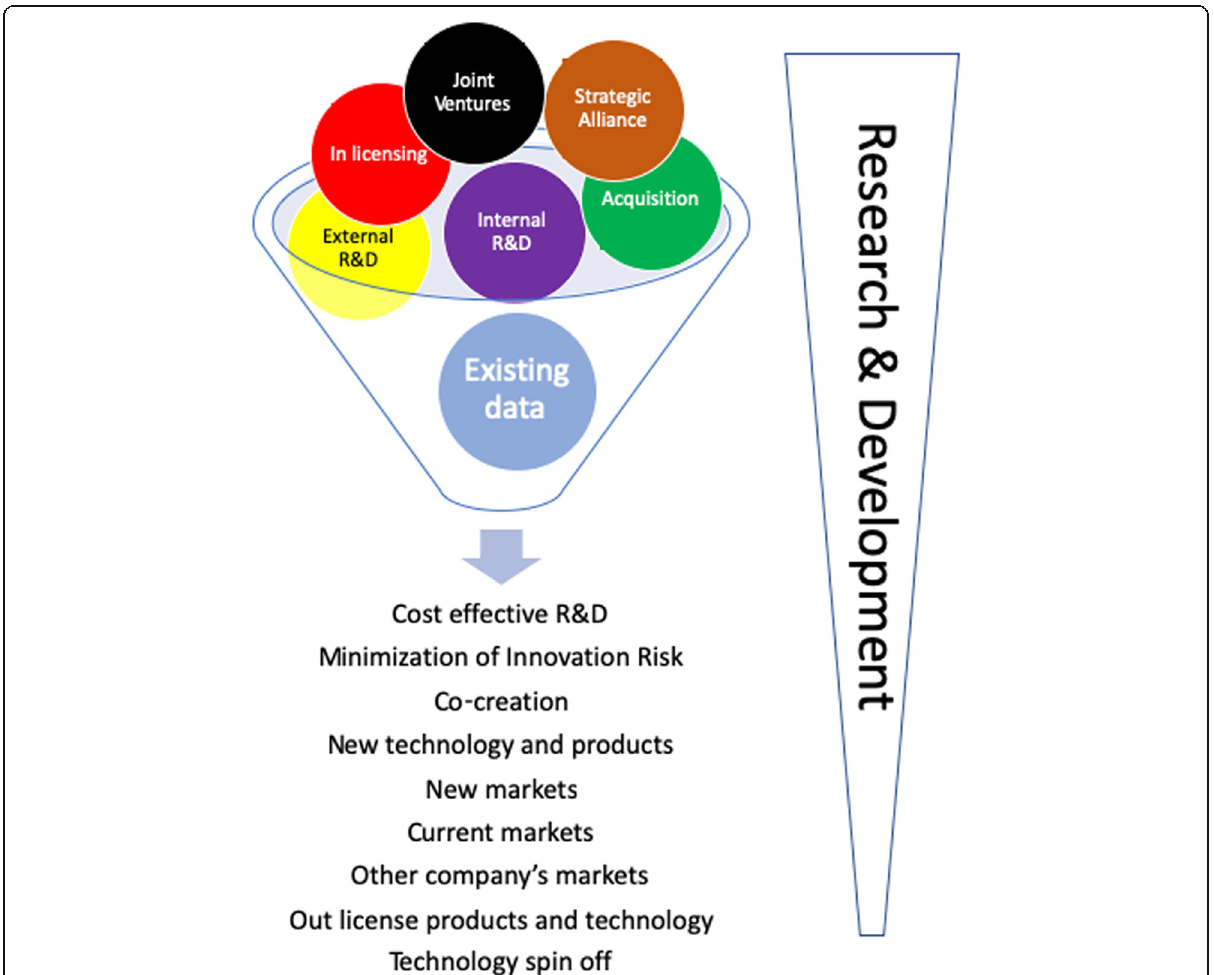
Fig. 4 Open Innovation Model emphasizes integrative science through collaboration, strategic alliance, open-sharing of internal R&D and external R&D, using existing knowledge (data), taking up other multifaceted approaches and accruing benefits from advances on different fronts of new drug discovery and development process to create internal and external knowledge and resources to create value and to capture a piece of that value. Because the open innovation model shares the innovation cost and minimizes innovation risk, it has the potential to self-sustain itself creating new technology and products for new markets or displacing existing products in the current markets as well as potential out licensing opportunities for the products and technology developed during this